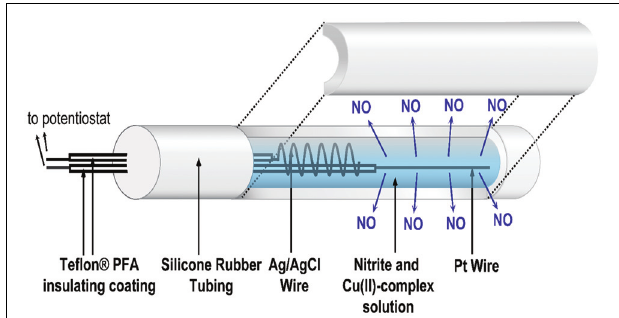
FIGURE 1 | Schematic of the electrochemical NO releasing catheter employed in this study, with a cutaway view showing the inner electrodes of the catheter that are capable of creating NO from inorganic nitrite via electrochemical reduction reaction mediated by a Cu(II)-ligand